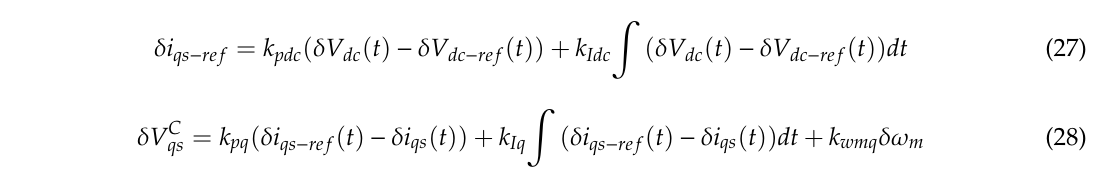
Figure 7. Small-signal block diagram of injected power into the grid.